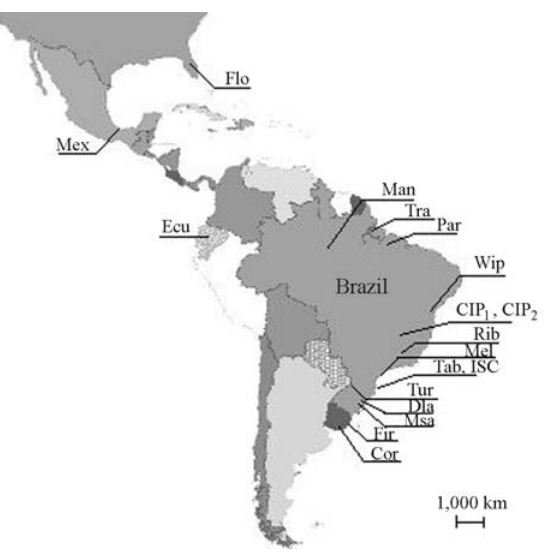
Figure 1 - Map of the Americas indicating the original collection sites of the Drosophila willistoni populations (see also Table 1).